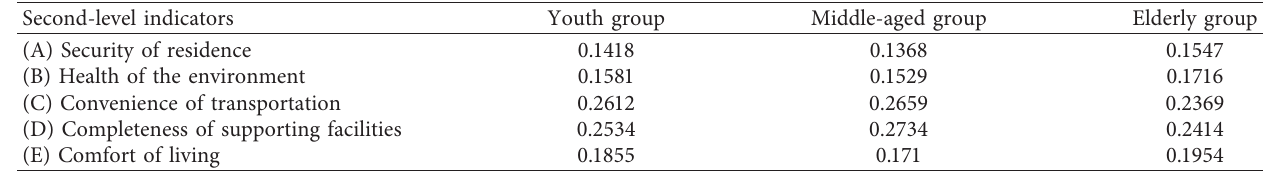
Table 3: The weights of second-level indicators considering the preferences of different age